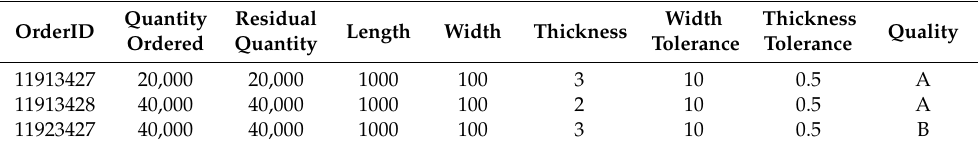
Table 3. Production order information.